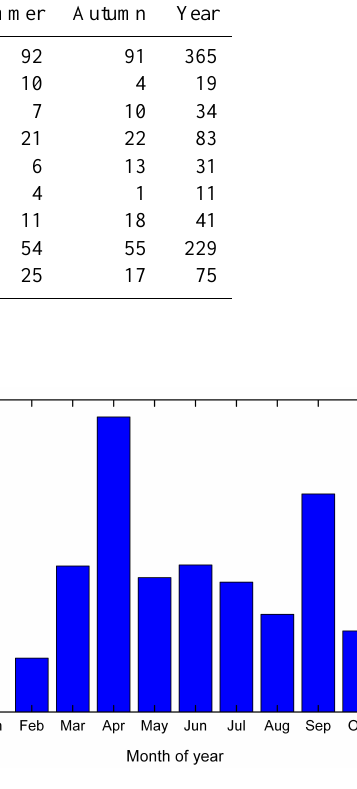
Fig. 7. Monthly mean new particle formation frequency in Budapest from 3 November 2008 to 2 November 2009.